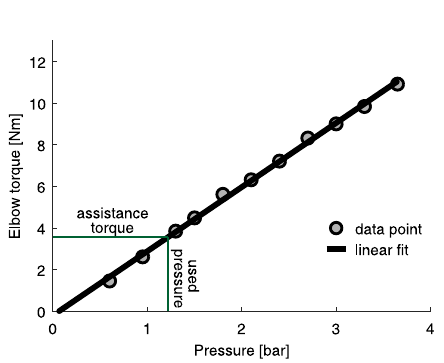
Figure 5. Relationship between actuator pressure and assistance torque. At 1.22 bar, one Carry actuator provides 3.6 Nm of elbow assistance